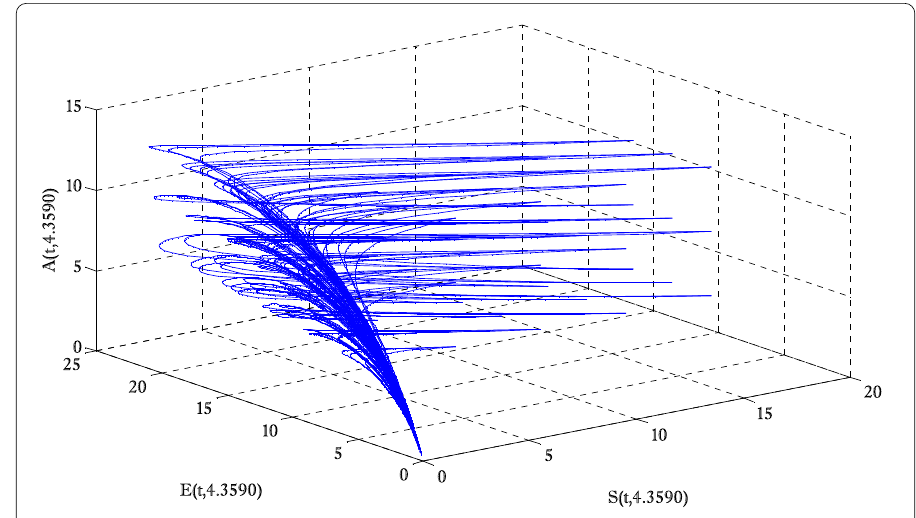
Figure 9 Three dimensional phase portrait of susceptible, exposed and asymptomatic individuals